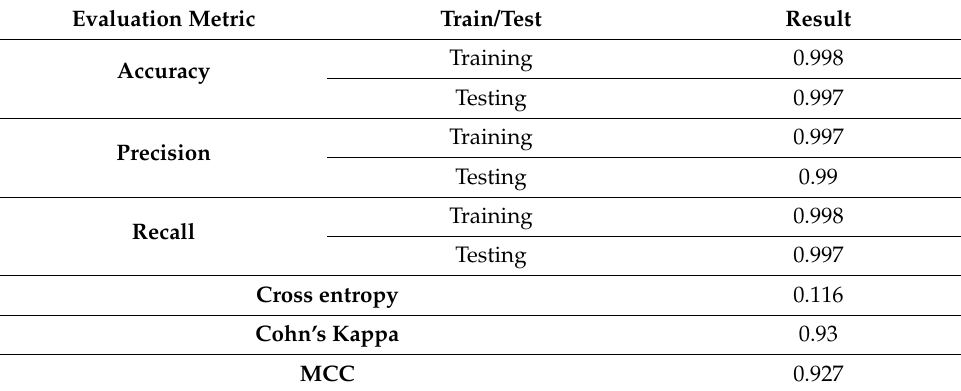
Table 5. Comparison of the Proposed Model with Benchmark and Other